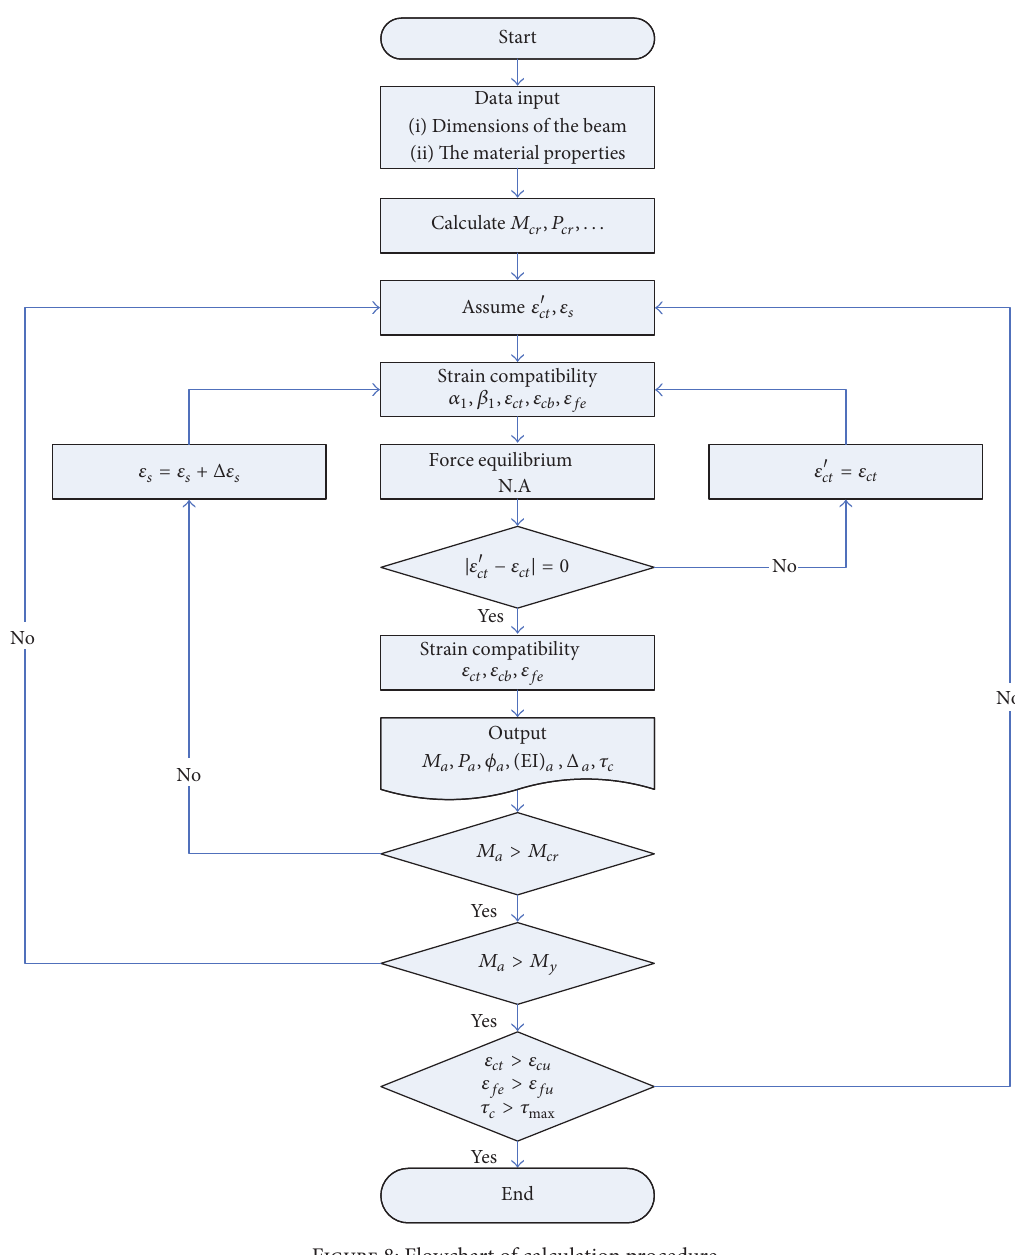
Figure 8: Flowchart of calculation procedure.